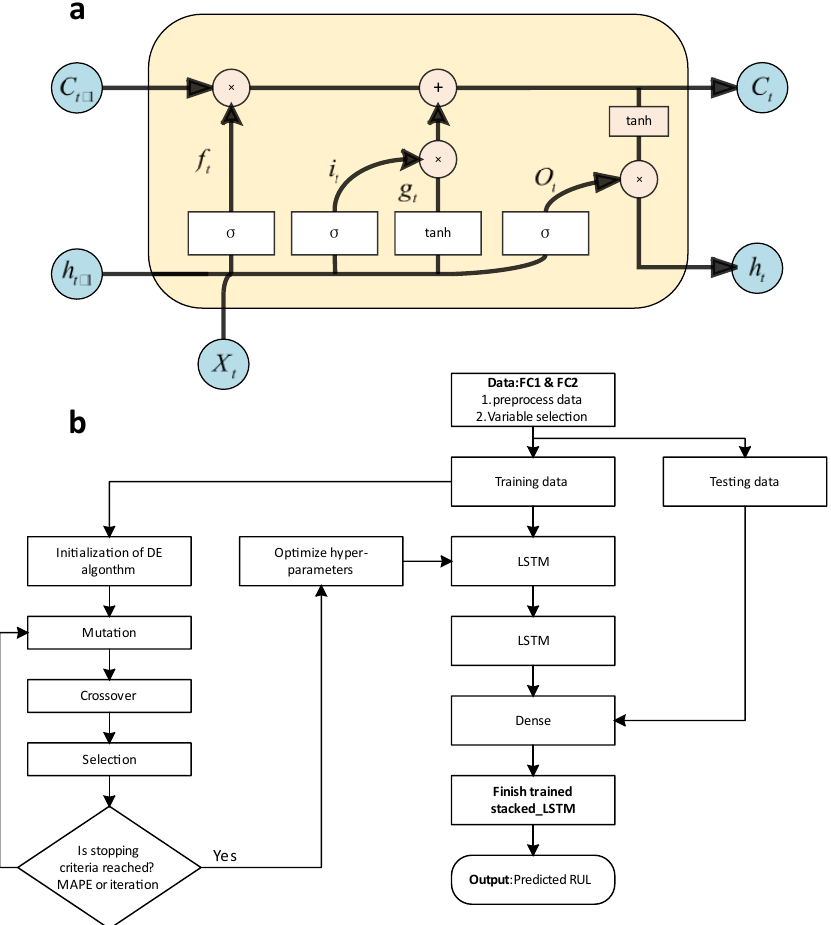
Figure 7. ( a ) The framework of LSTM; ( b ) RUL prediction using a stacked LSTM model. Reprinted with permission from Ref. [100]. Copyright 2020 Elsevier.